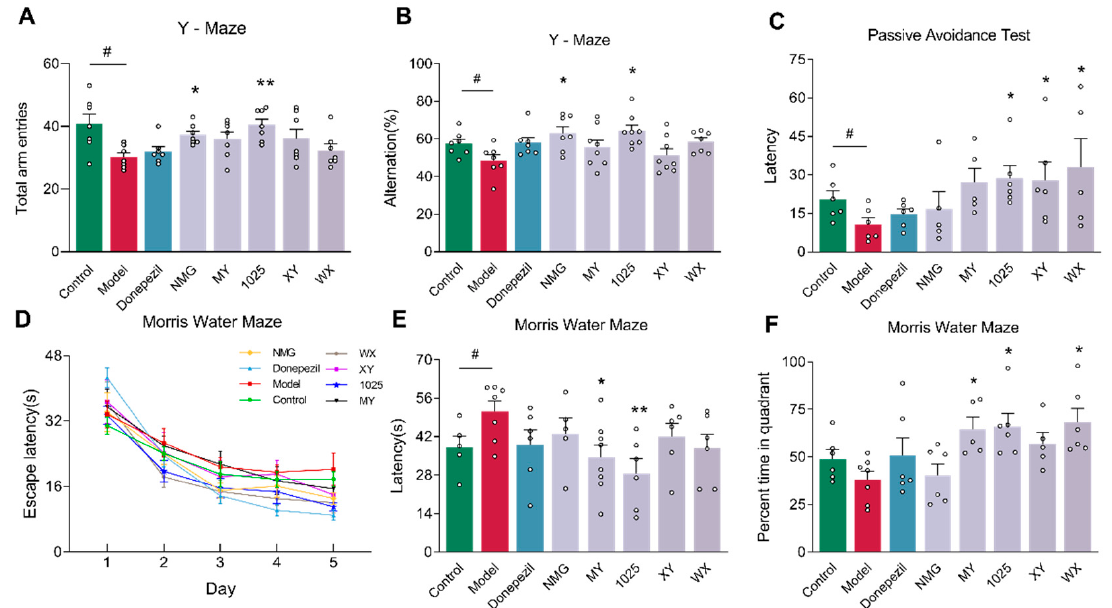
Figure 2. Bifidobacterium breve supplementation impacts the cognitive function and behaviors of mice. ( A ) Total arm entries in Y-maze test ( n = 6–8). ( B ) Spontaneous alternation behavior in Y-maze test ( n = 6–8). ( C ) Escape latency of passive avoidance test ( n = 6–8). ( D ) Mean escape latency to reach the platform in Morris water maze training trials ( n = 6–8). Mice were given four trials per day, and data represent the mean ± standard error of the mean (mean ± SEM) of four trials. ( E ) The escape latency during the probe phase (day 6) of the Morris water maze ( n = 6–8). ( F ) Percentage of time in the target quadrant during the probe phase of the Morris water maze ( n = 6–8). Data are presented as mean ± standard error of the mean (mean ± SEM). Control vs. model: # p < 0.05 by unpaired student’s t -test; * p < 0.05, ** p < 0.01 by one-way ANOVA for all groups.